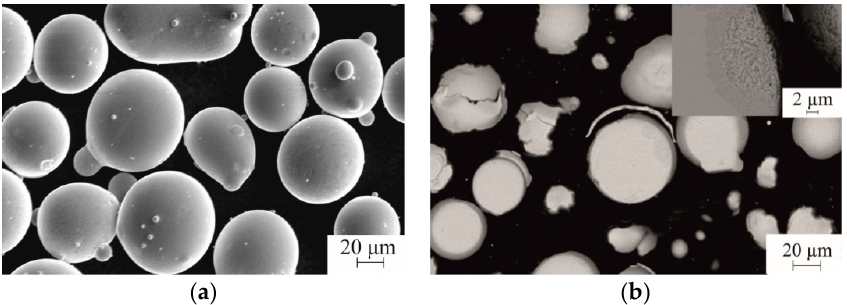
Figure 1. Scanning electron micrographs of the feedstock Fe 66 Cr 10 Nb 5 B 19 powder: ( a ) particle morphology; ( b ) particle microstructure.